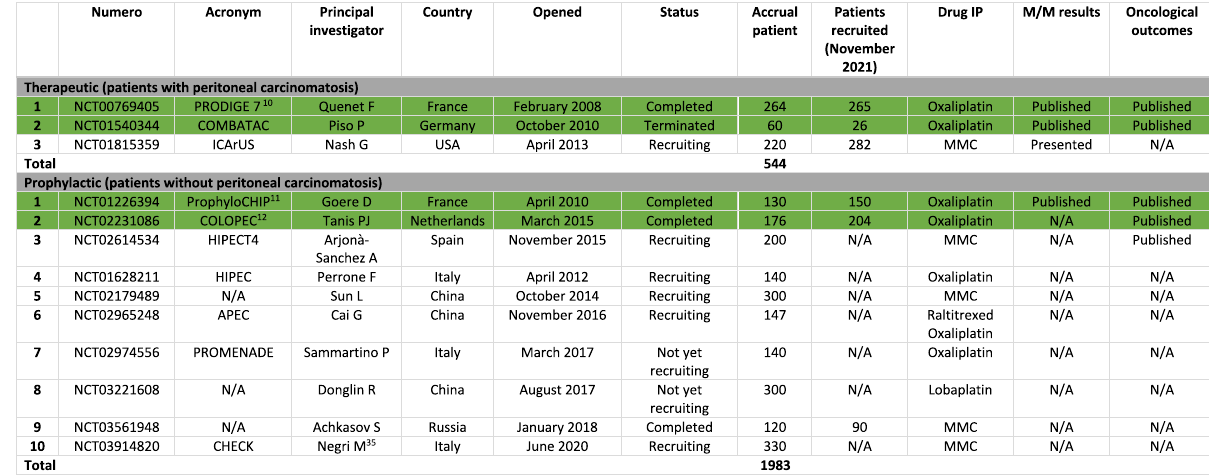
N/A, not available at date (November  ); MMC, mitomycin. Green: results published.